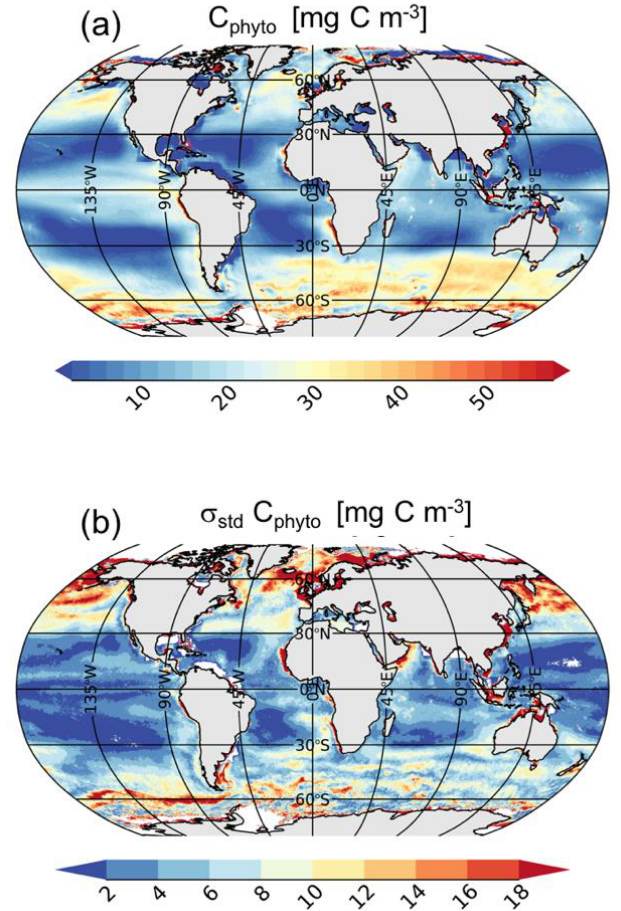
Figure 3. Annual global mean ( a ) and standard deviation ( b ) of C phyto . Note that at high latitudes the number of satellite observations used for the mean and standard deviation computations are lower than those used at low or mid-latitudes due to the winter darkness (i.e., high sun zenith angle). The amplitude of seasonal variations (i.e., interannual variability) of C phyto is shown in Figure 3b. Most of the variability is observed at high latitudes (e.g., Baltic Sea, Irish Sea, Norwegian Sea, North Sea), in the North Pacific and North Atlantic Oceans, and in the Southern Ocean, because std values are higher than 12 mg m −3 . The North Atlantic and Southern Oceans are characterized by high seasonal variations due to intense productive months followed by unproductive periods [47–49] (Figures S2–S13). In the North Atlantic Ocean, C phyto starts to increase in May, reaching the maximum values in June and July (> 50 mg C m −3 ) following the spring bloom. Then, C phyto decreases to the lowest values for the remainder of the year [47]. In the Southern Ocean, C phyto follows the typical seasonal cycle with high values during the most productive months which occur from November to March (> 50 mg C m −3 ). Highs are mostly observed in the Antarctic Circumpolar Current (ACC) and the Patagonia Shelf. Later, there is a decrease in C phyto from May to September (Figures S2–S13). Additionally, the northwestern Indian Ocean, known to be an Oxygen Minimum Zone, as well as the Benguela upwelling system, also show significant variability in C phyto , with std greater than 12 mg